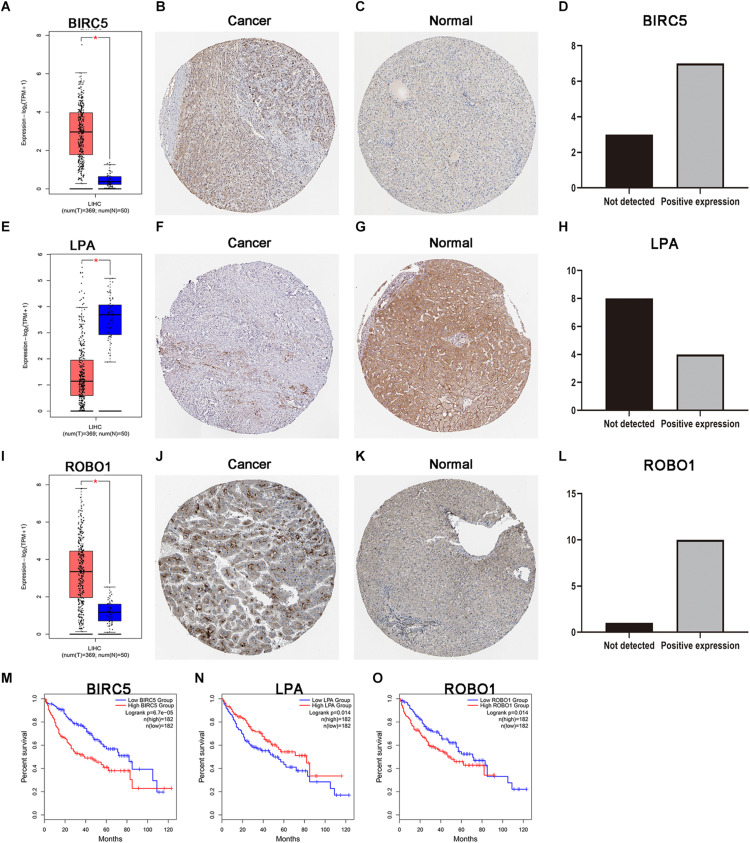
Expression and survival curve of BIRC5, LPA, and ROBO1. (A,E,I) BIRC5, LPA, and ROBO1 expression in normal and malignant liver tissue sampled from 419 patients using GEPIA. (B–D) Immunohistochemistry (IHC) staining for BIRC5 in tumor liver tissue and normal liver tissue from a Human Protein Atlas Portal. (F–H) IHC staining for LPA in tumor liver tissue and normal liver tissue from a Human Protein Atlas Portal. (J–L) IHC staining for ROBO1 in tumor liver tissue and normal liver tissue from a Human Protein Atlas Portal. (M–O) Kaplan–Meier survival curves of BIRC5, LPA, and ROBO1 in LIHC patients, respectively. P < 0.05 was as statistically significant.